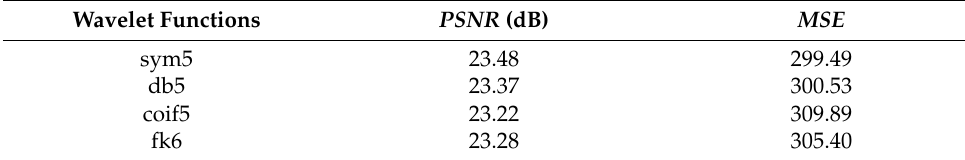
Table 1. The PSNR and MSE of different images denoised by different wavelet functions.